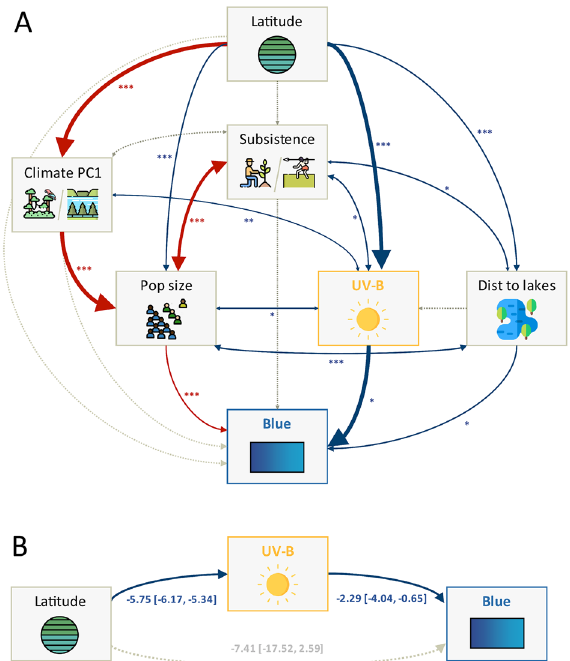
Figure 2. Mediation and path analyses for the presence of a distinct word for blue. (Panel A top): Path model with standardized coefficients (line thickness) and p -values (stars). Single-headed arrows represent regressions, while double-headed arrows represent covariances. Edges: solid blue = significant negative effects (at alpha- level 0.05), solid red = significant positive effects, and dotted gray = not significant. The thickness of the line indicates effect size, with a thick line indicating an effect size > = 0.5 and thin effect size < 0.5 ; significance stars near each arrow (*** for p < = 0.001 ; ** for p < = 0.01 and * for p < = .0.05 ). (Panel B bottom):